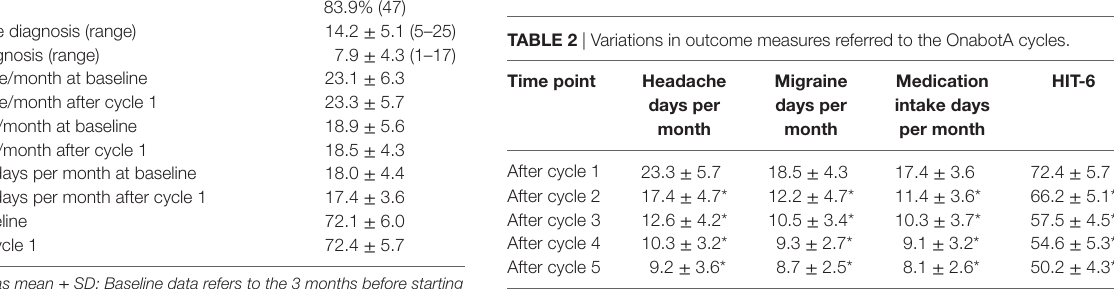
TaBle 1 | Baseline demographic and clinical data ( n = 56). Mean age, years (range)